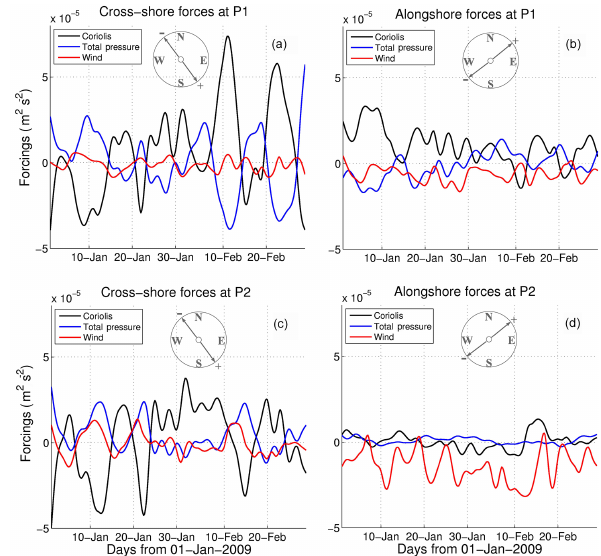
Figure 13. Variations in Coriolis force, total pressure, and wind in the cross-shore direction at P1 (a) , the alongshore direction at P1 (b) , the cross-shore direction at P2 (c) and the alongshore direc- tion at P2 (d) according to Eq. (5). The gray pointers indicate the alongshore and cross-shore directions of dynamical effects in the Earth coordinate